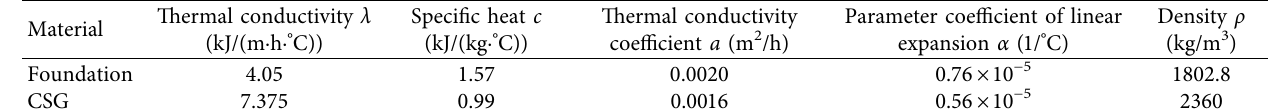
Table 5: The thermodynamic parameters of CSG dam and